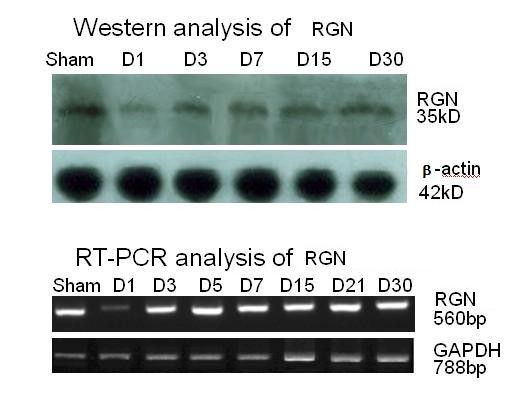
Time course of the level of protein and mRNA of Rgn in regenerating mouse liver following 50% PH. Liver samples from either sham-operated or 50% PH group recovered for different time period were analyzed by Western blot (upper) or RT-PCR (lower) for detecting the protein and mRNA of Rgn, respectively, as described in Methods. β-actin and GAPDH was probed in Western blot and RT-PCR, respectively, as a reference protein.